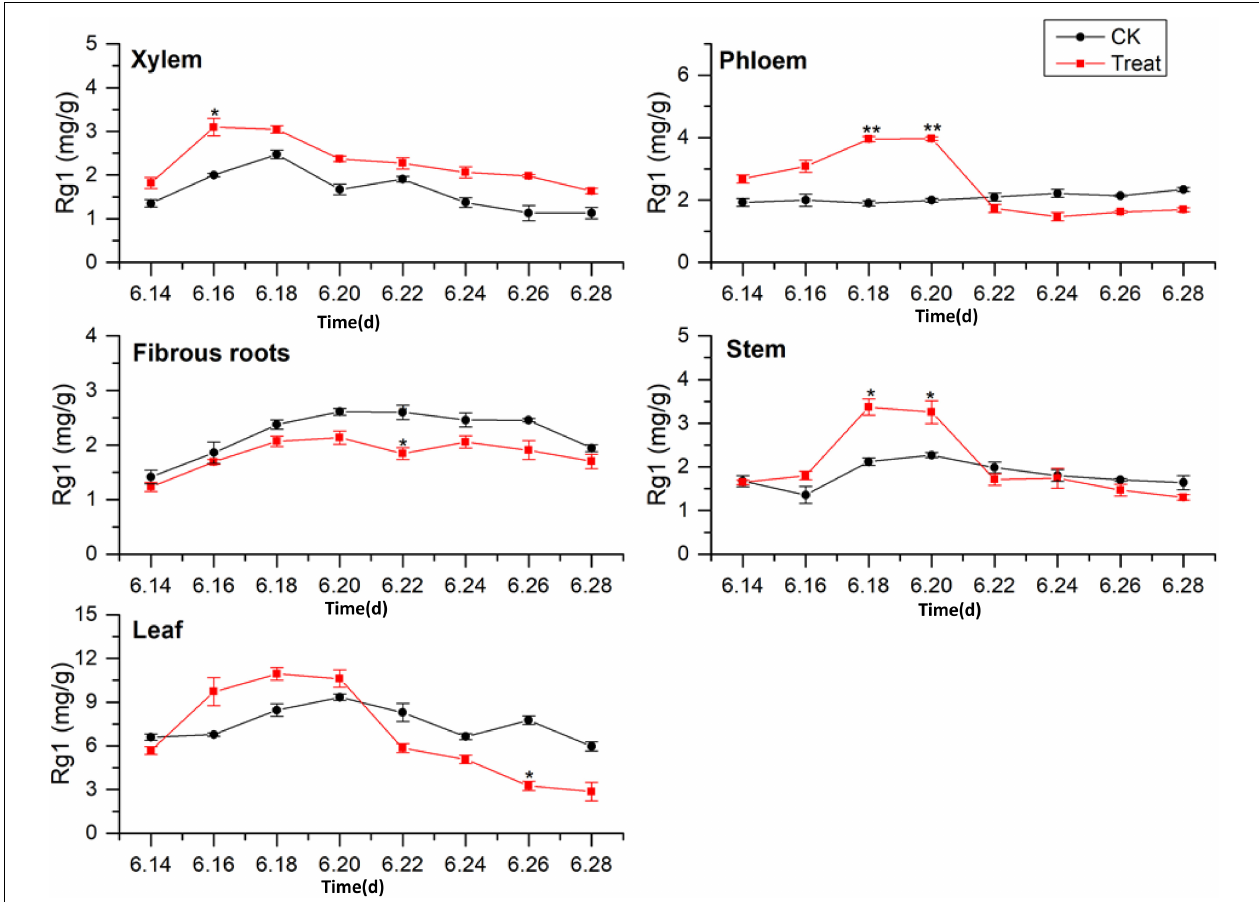
FIGURE 3 | Effects of cold stress on Rg1 in different tissues of flowering ginseng. The X axis represents the sampling time. * p < 0.05 and ** p < 0.01, compared with control group. The data are expressed as the mean ± SD ( n = 3).